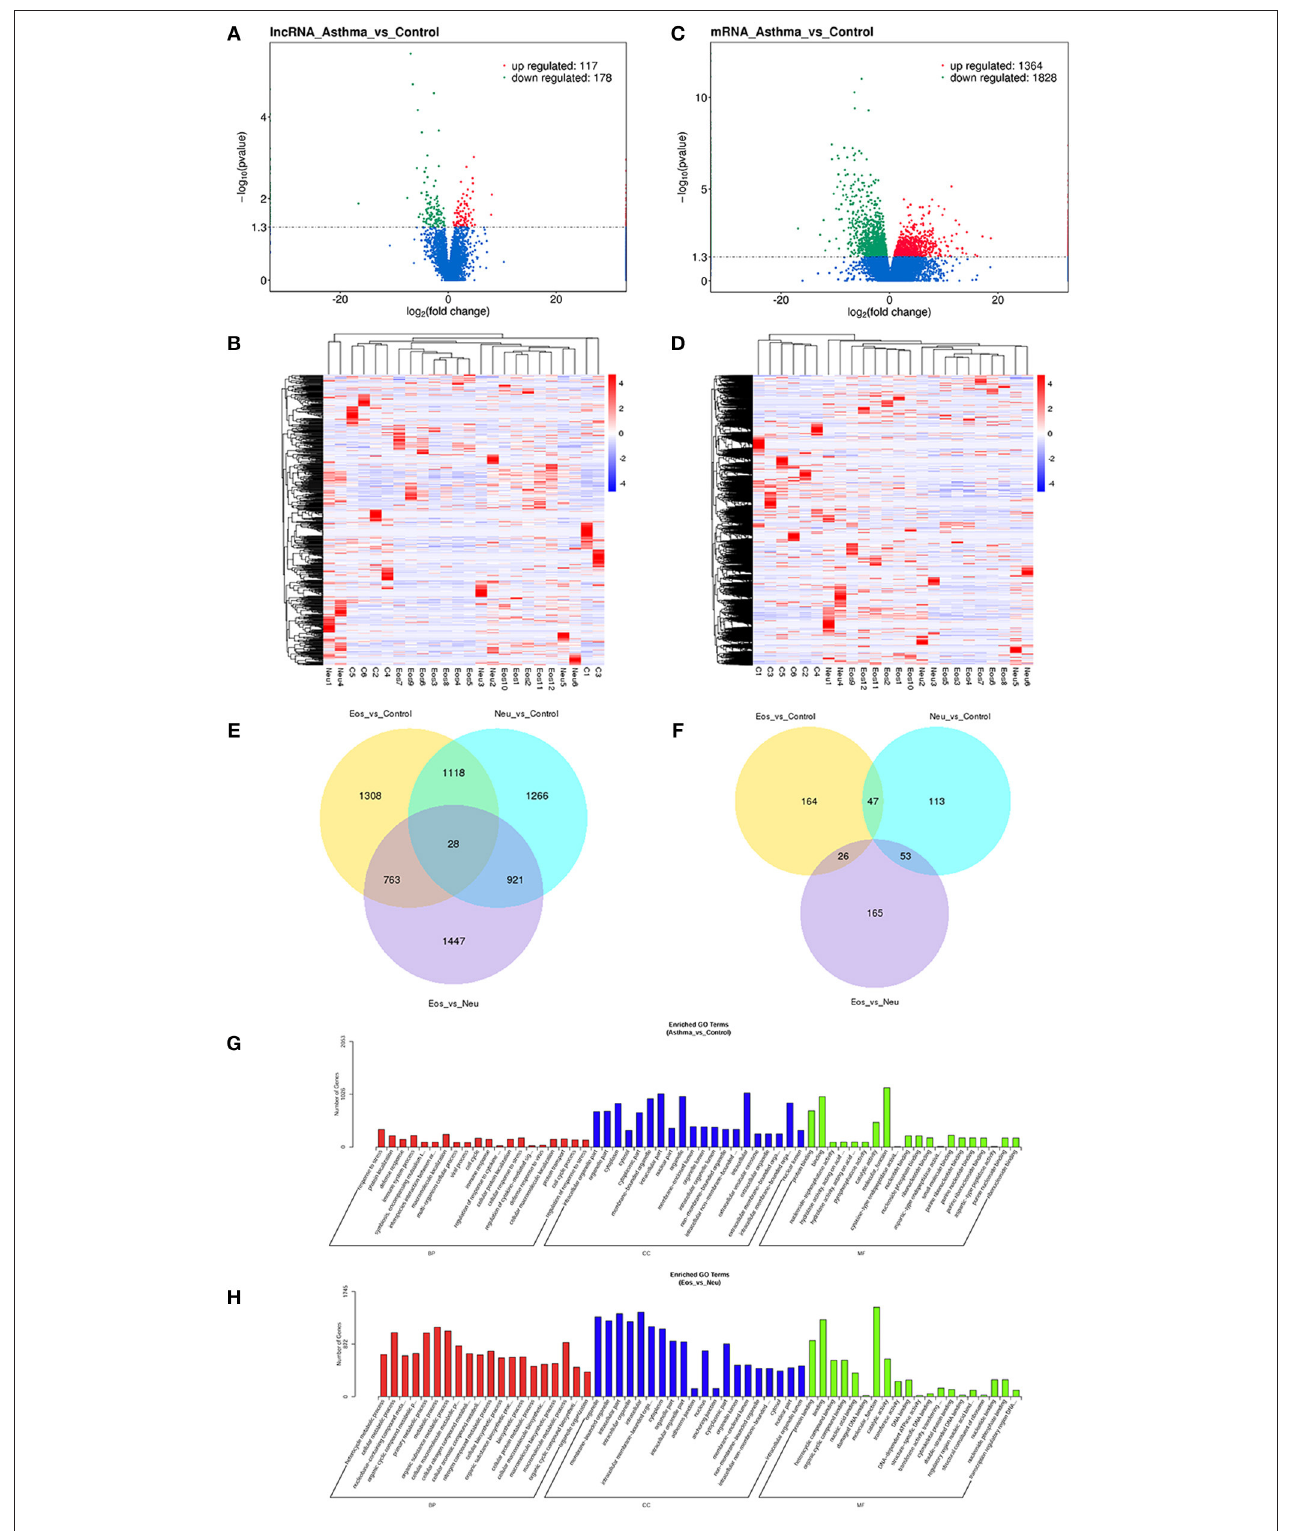
FIGURE 1 | (A) Volcano plot assessment of lncRNA expression between asthma and control groups. Red spots indicate a > 2.0-fold change in lncRNA expression between asthma and control groups. Green spots indicate a < 0.5-fold change between asthma and control groups. (B) Heat map analysis of differentially expressed lncRNAs between asthma and control group. Blue indicates low lncRNA expression and red indicates high lncRNA expression. (C) Volcano plot assessment of mRNA